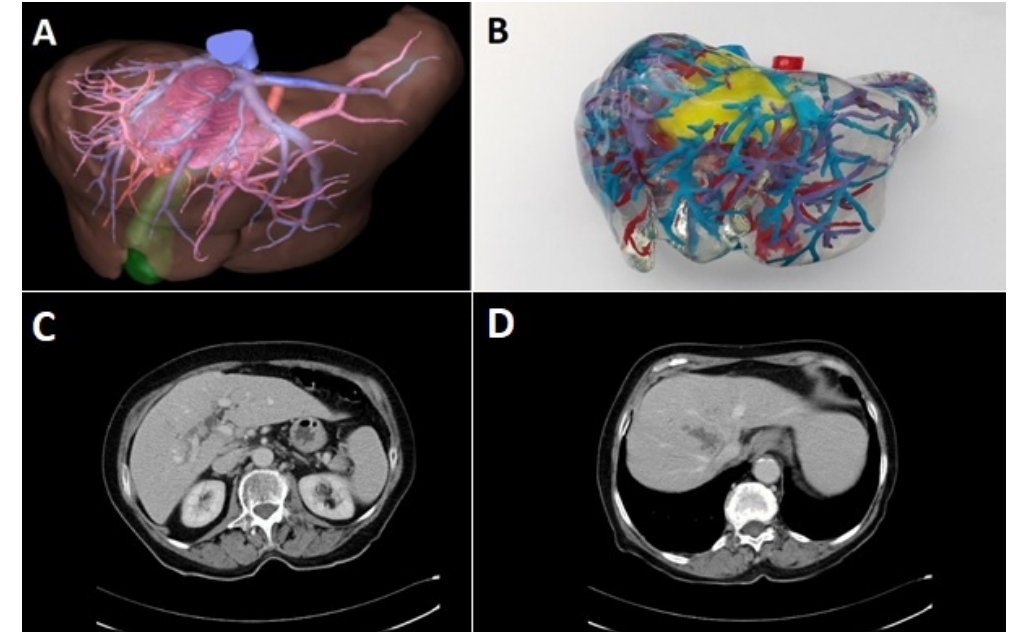
Figure 1. Preoperative 3D reconstruction as a PDF presentation ( A ) and 3D-print ( B ) with stained polyurethane rubber of the liver as well as CT-scan ( C , D ) in a 70-year-old patient with iCCA that infiltrated the right and middle hepatic vein and had contact to the left hepatic vein. Preoperative volumetric analysis of the segments 2/3 revealed a remnant volume of 563 mL. Resection was performed as an extended right-sided hemihepatectomy with hilar resection and reconstruction of the left portal vein and the medial of two branches of the left hepatic vein.